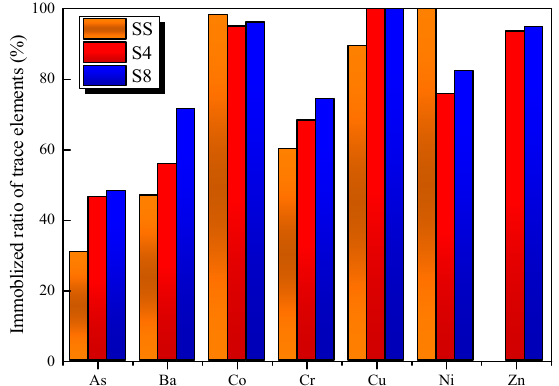
Figure 7. The immobilized ratio of trace elements in ash/clinker during the calcinations process of raw SS, sample S4 and sample S8.